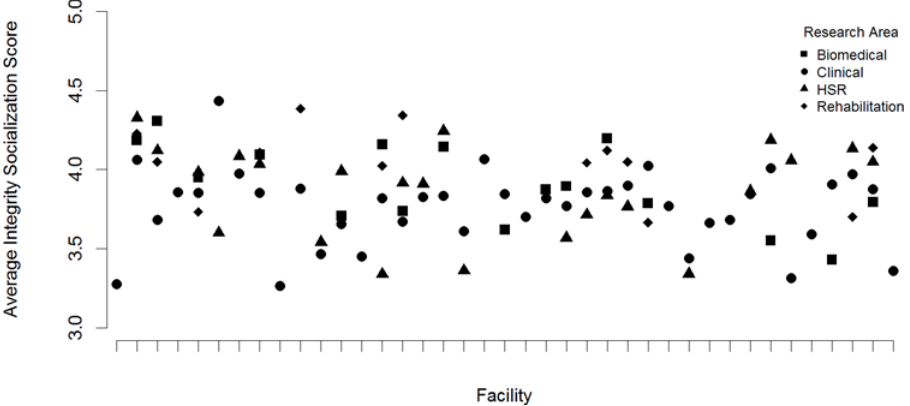
Fig 1. Within Facility Variability in Integrity Socialization Scale, by Area of Research. Research Areas: Square = Biomedical Circle = Clinical Triangle = HSR Diamond = Rehabilitation. Note: Observations for two facilities omitted due to insufficient group size to